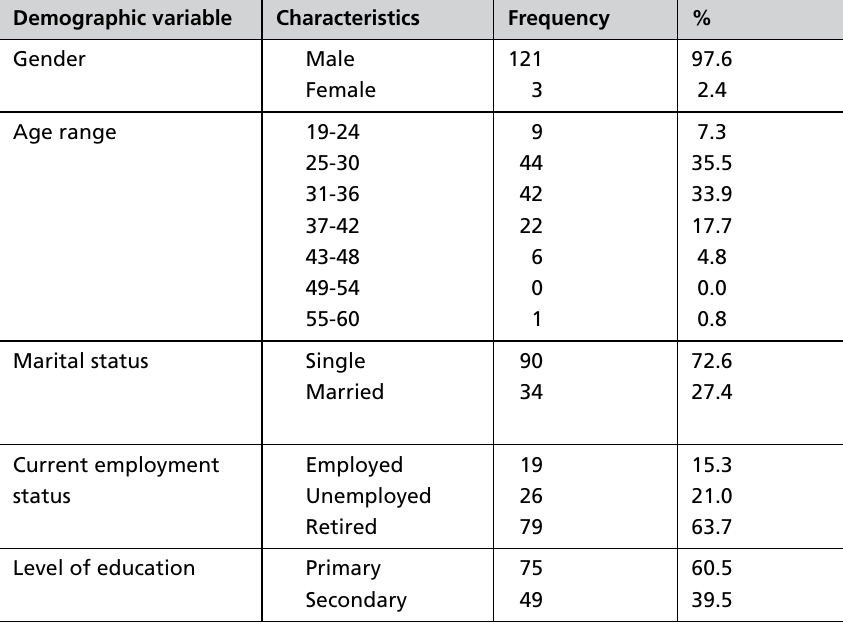
Table 1: Demographic information of the sample (n=124)